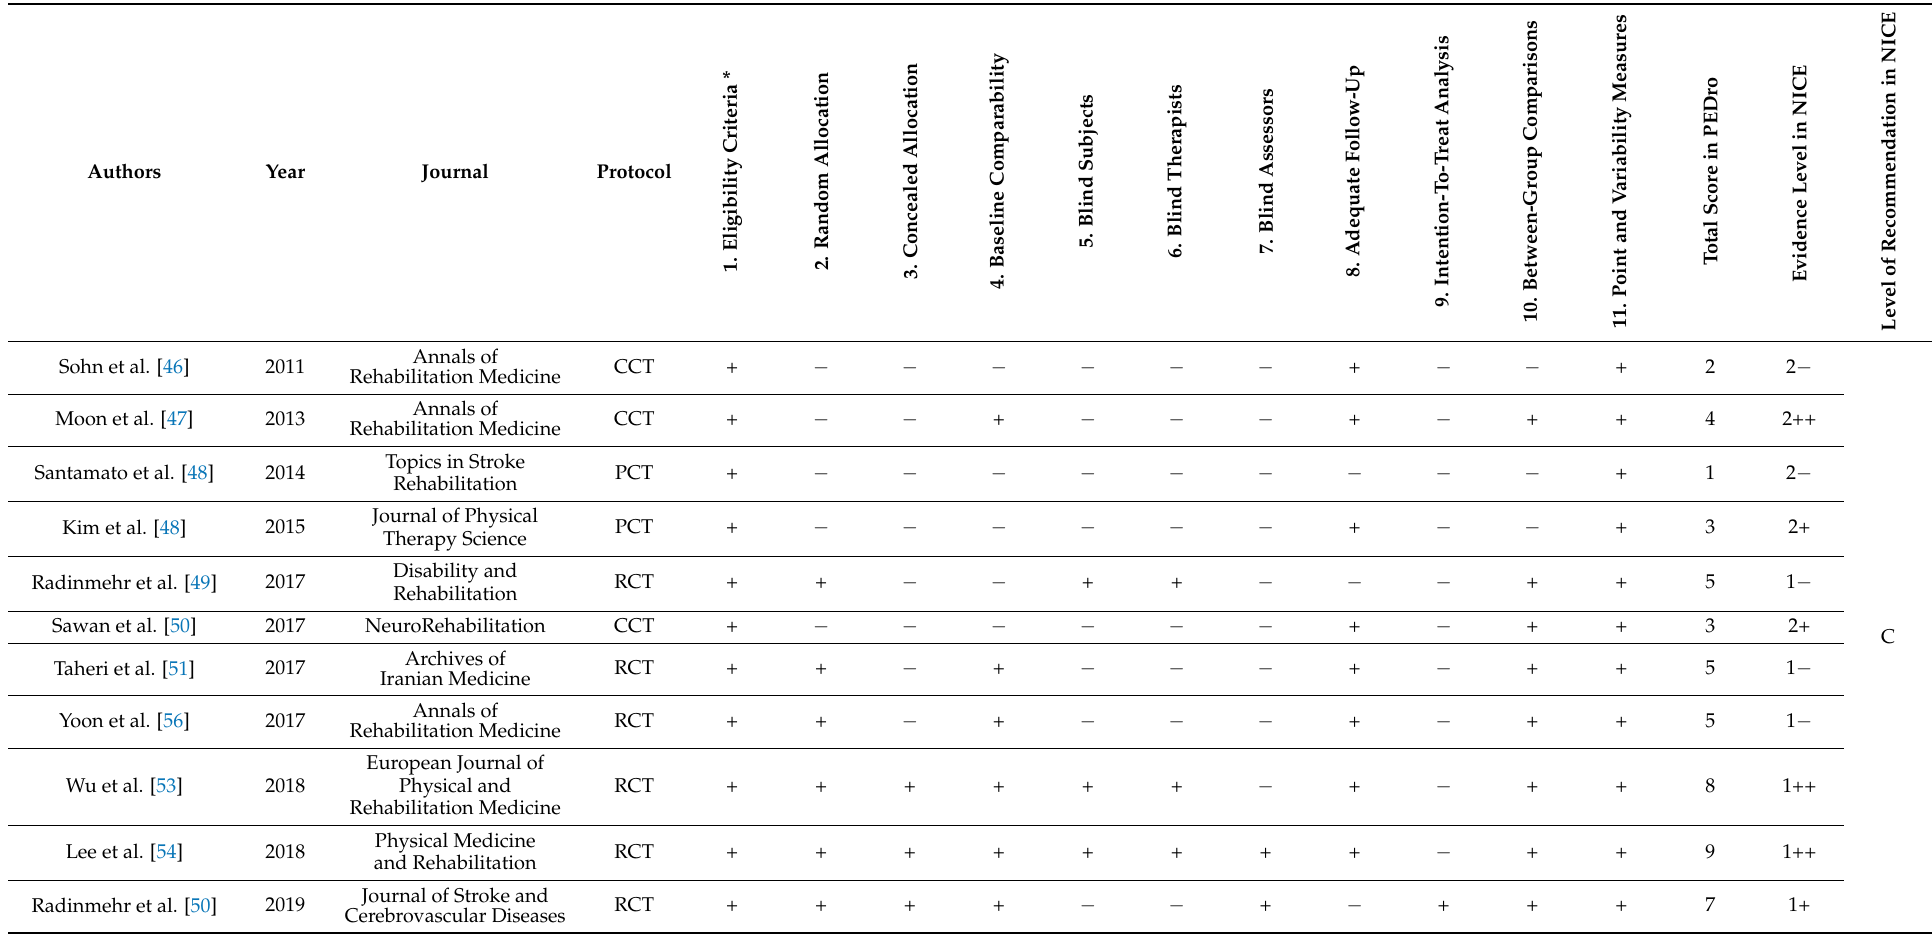
Table 6. Lower limb—methodological quality and level of evidence of